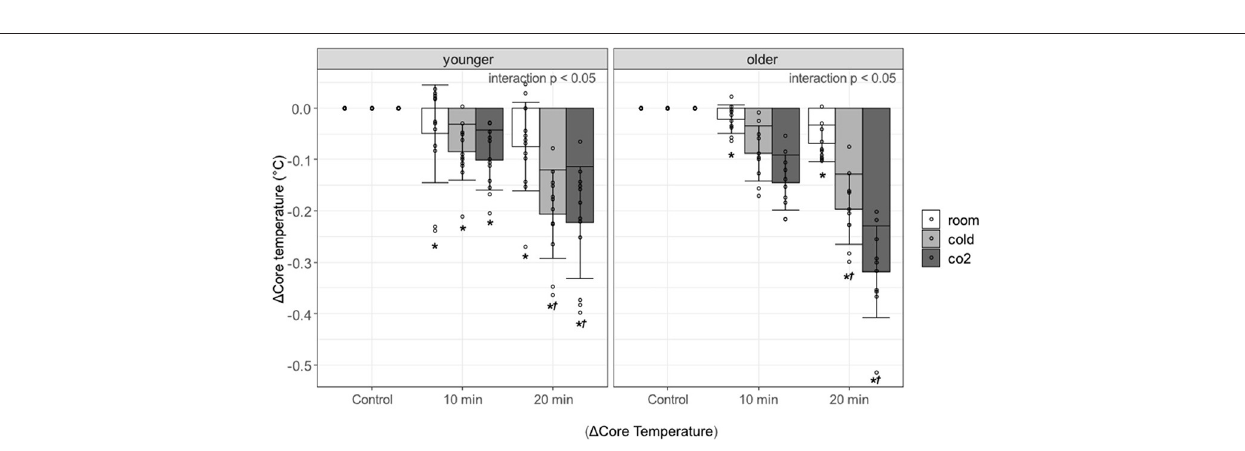
FIGURE 3 | Changes in core temperature against control period, associated with age, type of water, and period. Values are shown as mean ± standard deviation, * p < 0.05 vs. control period, † p < 0.05 vs.